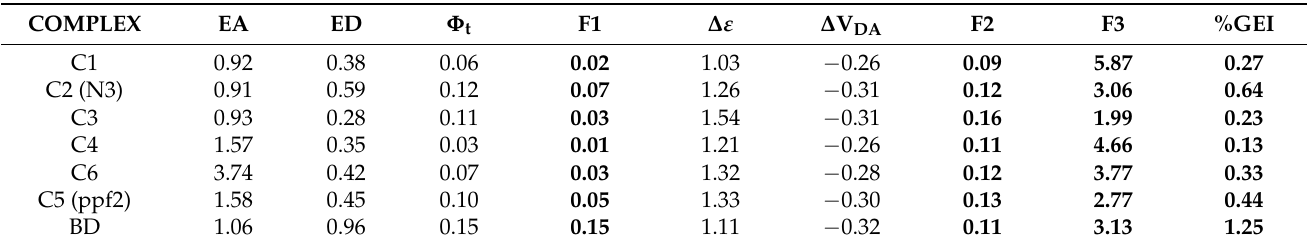
Table 5. Calculated values for the Global Efficiency Index (GEI) has the product of F1, F2, and F3